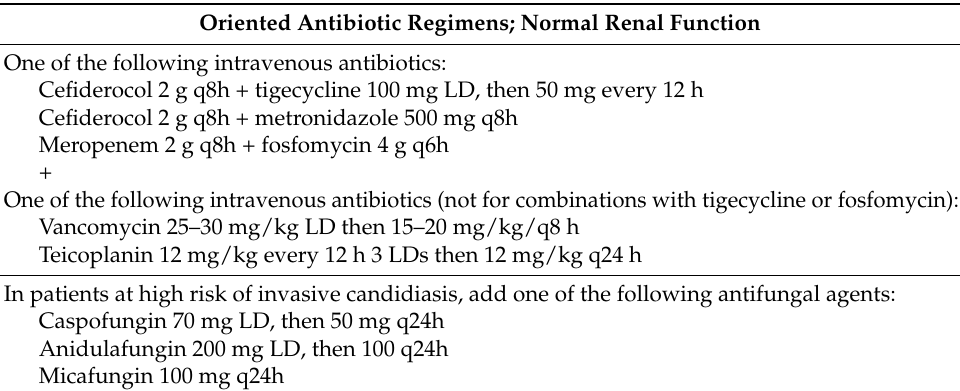
Table 7. Patients with IAIs with known colonisation by MBL-producing P. aeruginosa . Oriented Antibiotic Regimens; Normal Renal Function